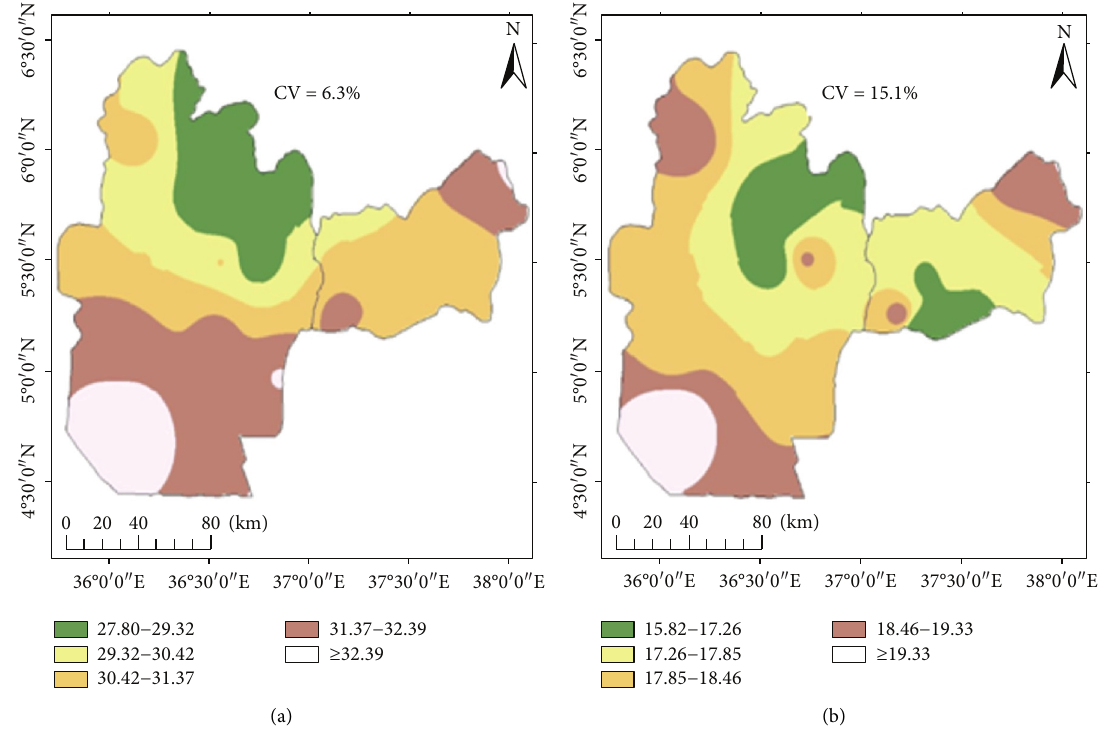
Figure 4: Spatial distribution and variability of mean annual maximum and minimum temperature of Southwest Ethiopia (1983–2016). (a) Annual maximum temperature ( ° C). (b) Annual minimum temperature ( ° C).